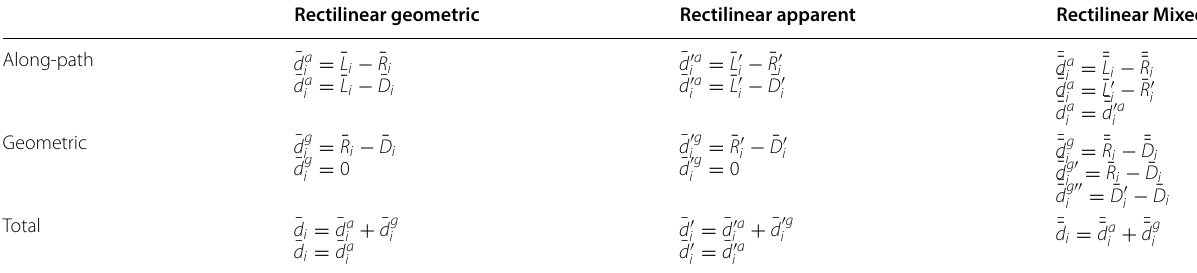
Table 4 Definition of rectilinear interferometric atmospheric delays Rectilinear geometric Rectilinear apparent Rectilinear Mixed Along‑path